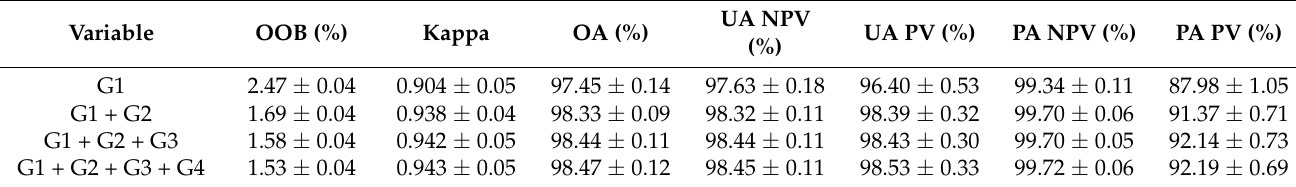
Table 2. Validation parameters for the model trained model with different variables sets.